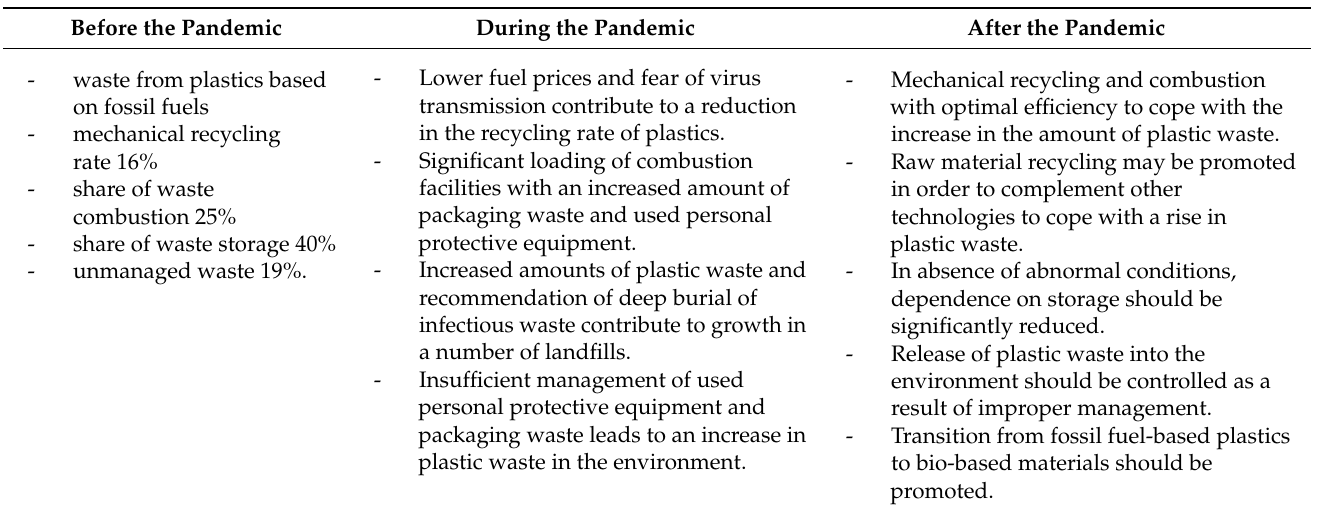
Table 4. Impact of coronavirus pandemic on trends in plastic waste